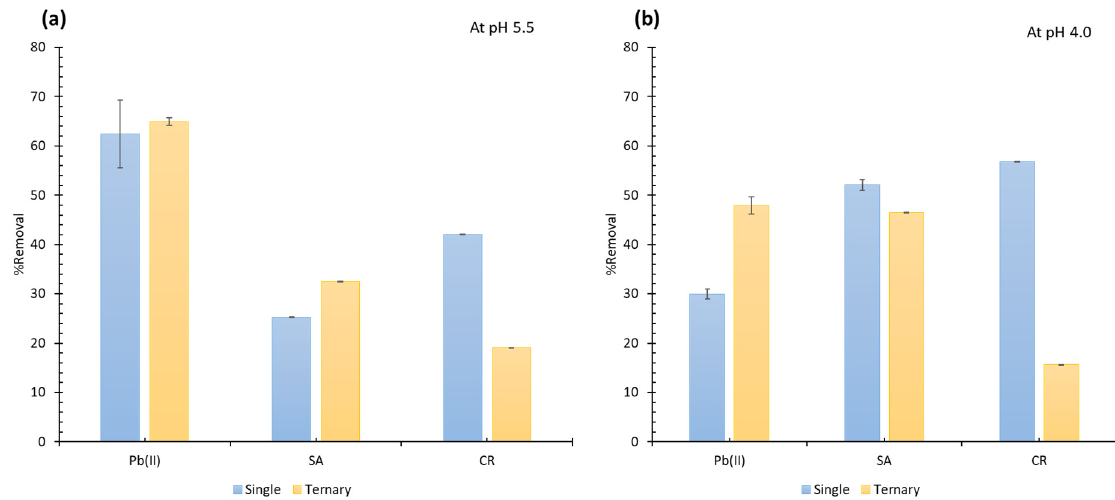
Figure 6. Adsorption of the tested contaminants in single and ternary systems at pH 5.5 ( a ) and 4.0 ( b ) using a 3 g/L adsorbent dose and an initial concentration of 50 ppm at 25 ± 2 °C. Error bars are expressed as mean value ± SD ( n = 3). Table 5. Selectivity coefficients of the tested contaminants in the ternary system.